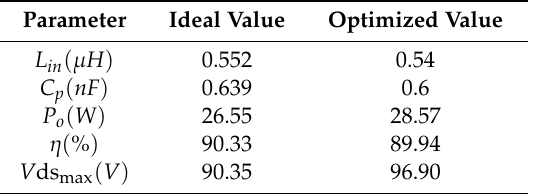
Table 3. Parameter values of PCL before and after optimization.